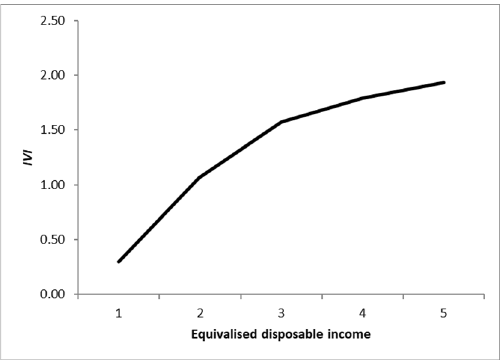
Figure 8. Variation of the IVI index for energy consumption per inhabitant by group of cities.